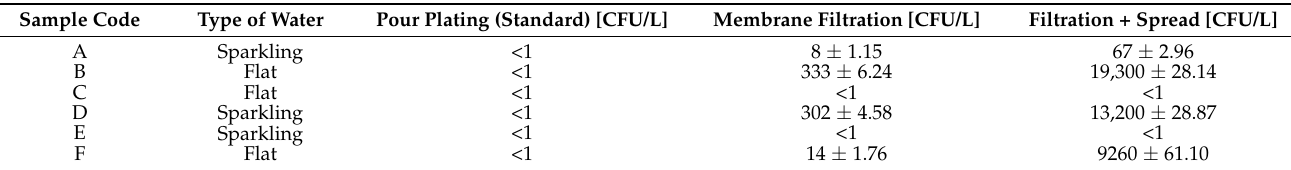
Table 1. Results expressed in CFU/L were obtained by quantitative analysis using the three methods. Limit of detection: 1 CFU/L (whereas a plate was free of microorganisms, the value < 1 was indicated). Sample